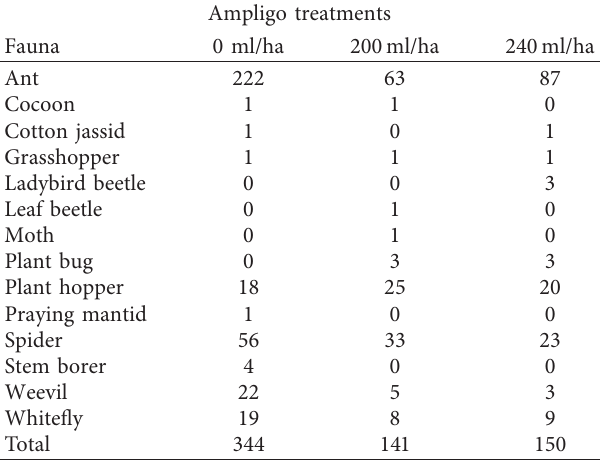
Table 4: Abundance of nontarget insects collected on maize during the sampling period.